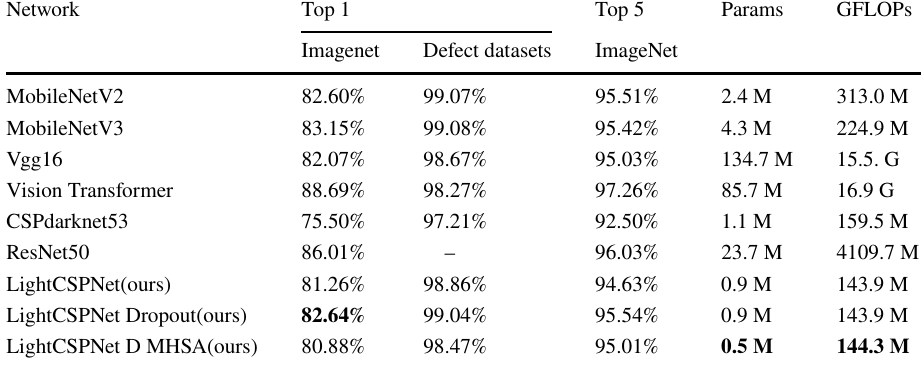
Table 3 Model performance on the ImageNet100 and Defect datasets